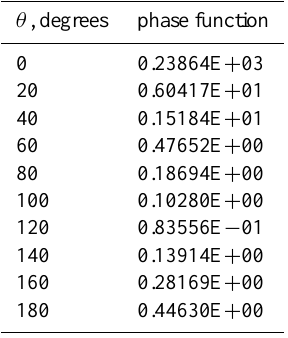
Table A2. Tabular data for the aerosol model used. The phase function at λ = 550 nm.